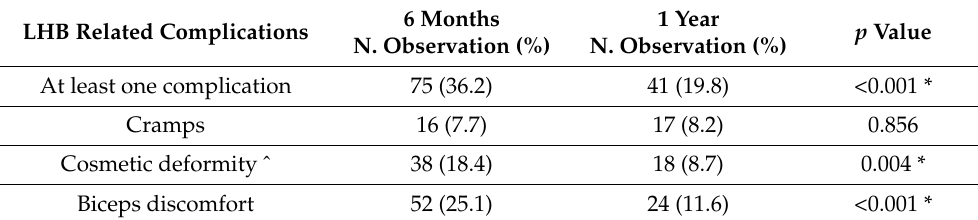
Table 2. LHB-related complications.